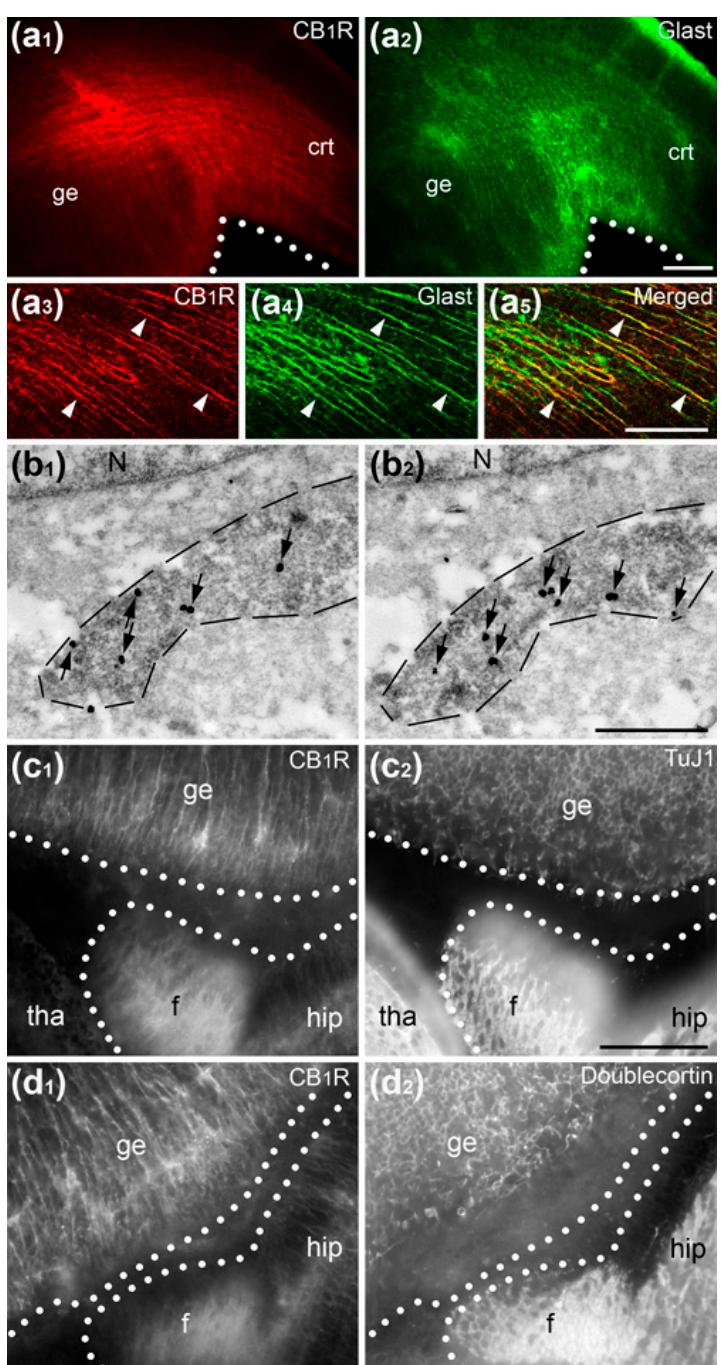
Figure 2. Suboptimal conditions of immunolabeling results in the illusion of CB 1 R expression in E15 mouse embryo radial glia. ( a 1 – a 5 ) Colocalization of CB 1 R-L15 (red) and Glast (green) immunolabeling in radial processes in the ganglionic eminence (ge) and the cerebral cortex (crt). ( a 3 – a 5 ) High power immunofluorescence images of double labeled radial processes (arrowheads) in the ganglionic eminence. ( b 1 – b 2 ) Serial electron micrographs of a radial process (underlined with dashed lines) double-labeled for CB 1 R-L15 (immunogold / silver particles, arrows) and Glast (di ff use DAB immunoperoxidase labeling) in the thalamus. ( c 1 , c 2 , d 1 , d 2 ) Double immunofluorescence reveals dissimilar patterns for CB 1 R-L15 labeling versus neuronal markers TuJ1 ( c 1 , c 2 ) and doublecortin ( d 1 , d 2 ) in the ganglionic eminence (ge), thalamus (tha) and hippocampus (hip). Ventricular surfaces are underlined with white dotted lines. Abbreviations: f, fimbria; N, cell nucleus. Scale bars: ( a , c , d ) 100 µ m and ( b ) 1 µ